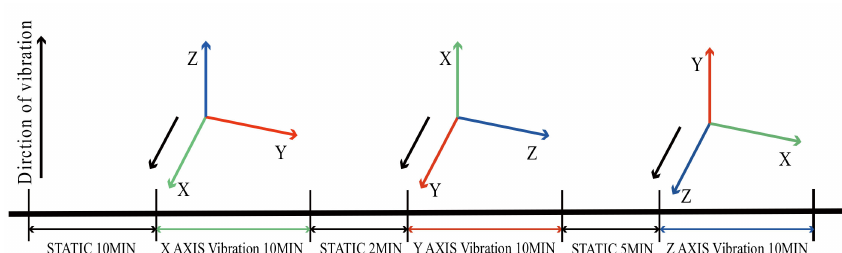
Figure 3. The vibration experiment process.